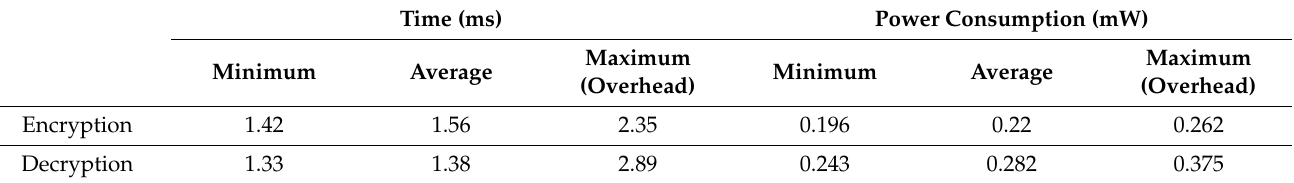
Table 5. Time and power consumption during encryption and